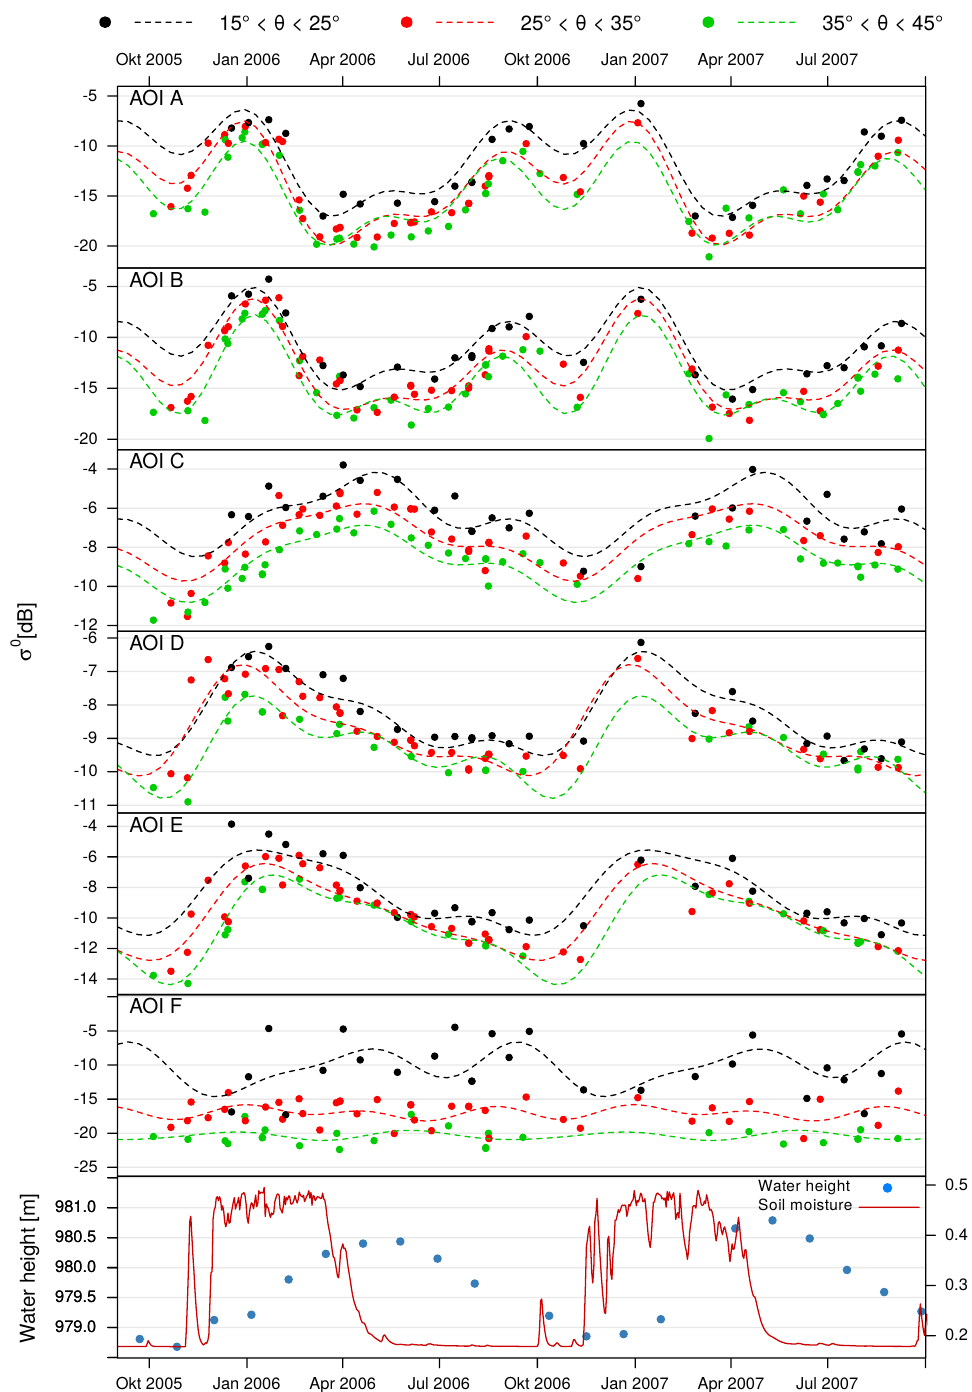
Figure 5. ASAR σ 0 time series for different local incidence angle ranges in AOIs A–F as well as soil moisture from ERA-Interim/Land and altimeter water heights in the Kafue Flats (bottom). Dashed lines show fitted harmonic